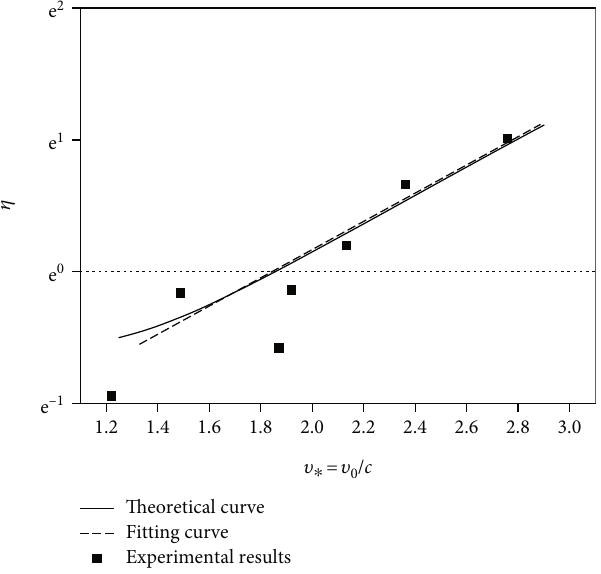
Figure 7: Experimental and theoretical coe ffi cient η vs. scale velocity υ ∗ .